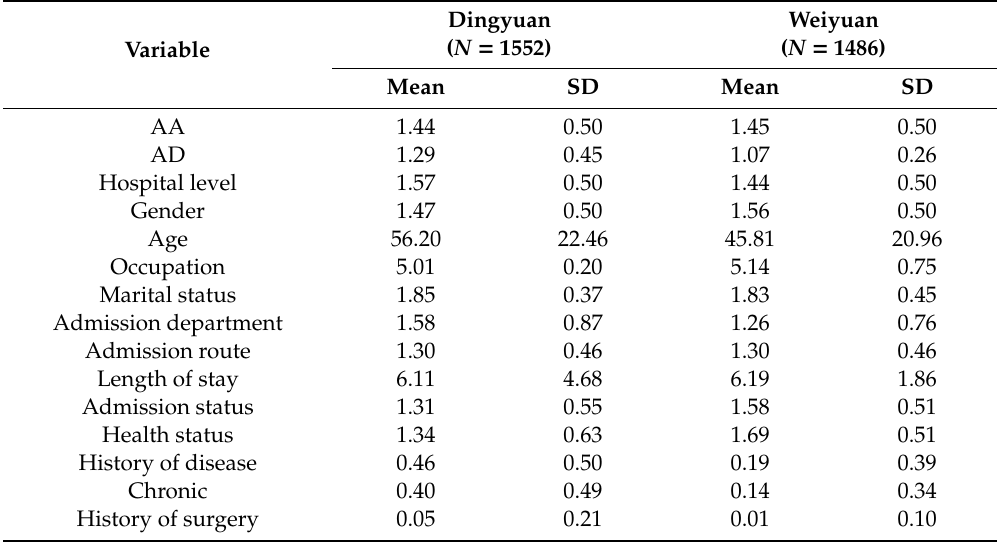
Table 4. Characteristics of study sample after payment reform for